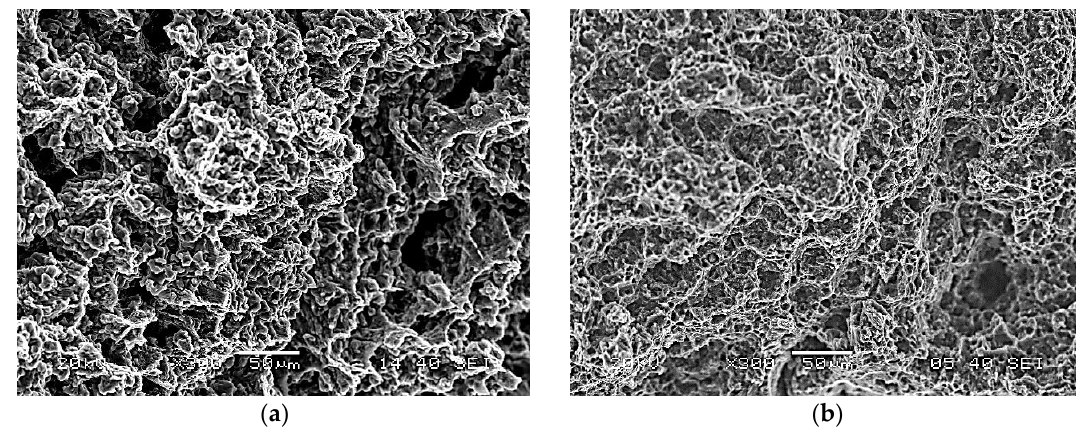
Figure 9. SEM fractographs of the fracture surface of AZ31-2Ca-1.5NAl composite tested in tension at 400 C/0.0003 s − 1 (Domain 2) and ( b ) 350 C/2.3 s − 1 (Domain 3).